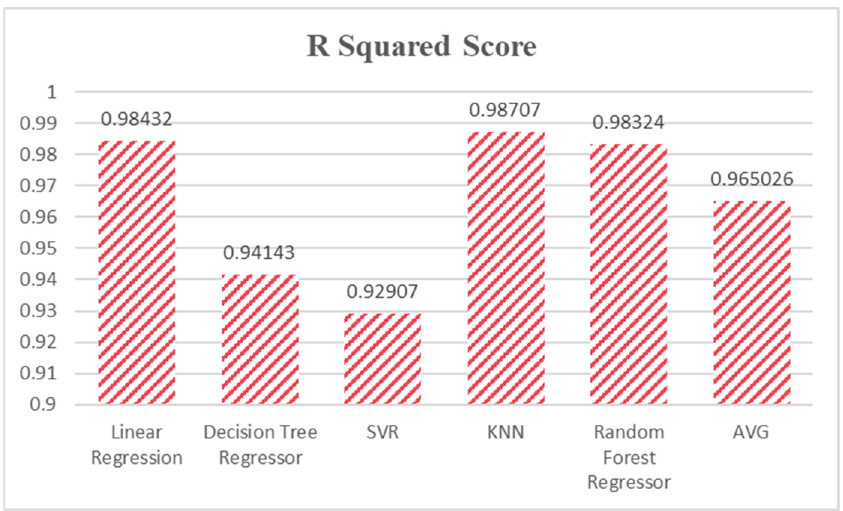
Figure 3. R Squared index of five prediction models.